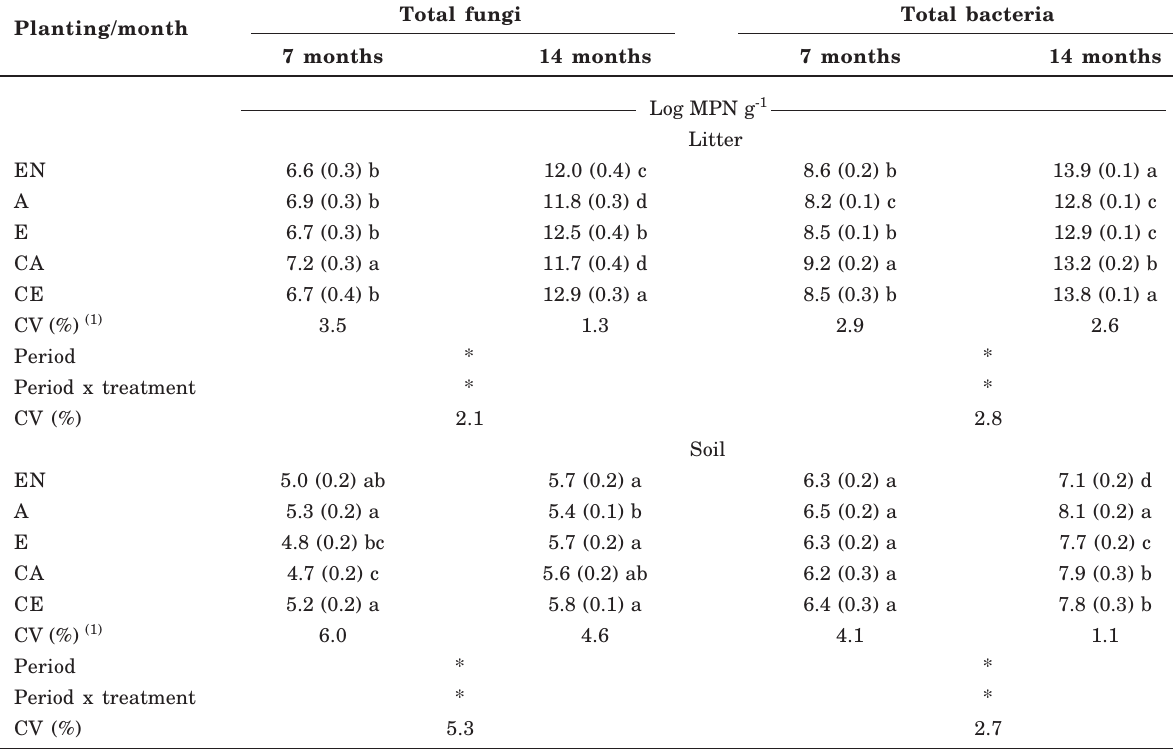
Table 2. Total fungi and bacteria quantified in the soils and litter of mixed and pure plantations of Eucalyptus grandis and Acacia mangium seven and 14 months after